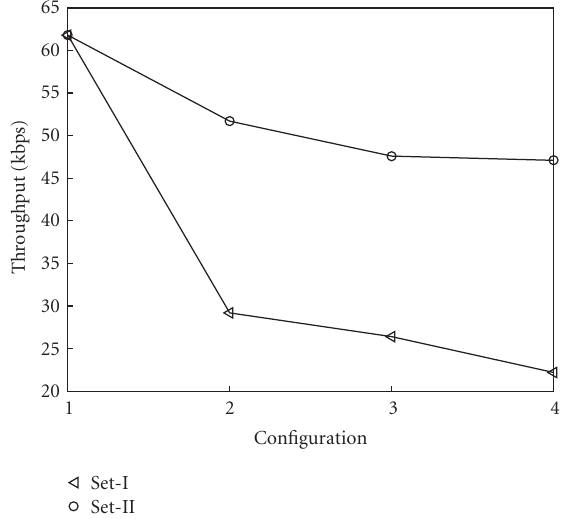
Figure 13: Measurement results on the throughput.